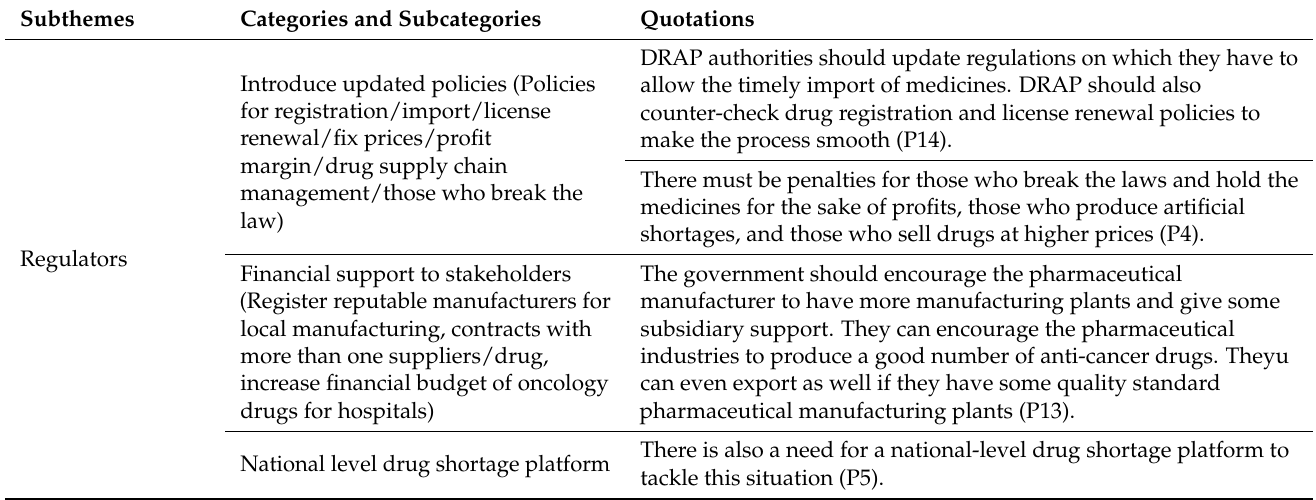
Table 6. Theme 5: Future